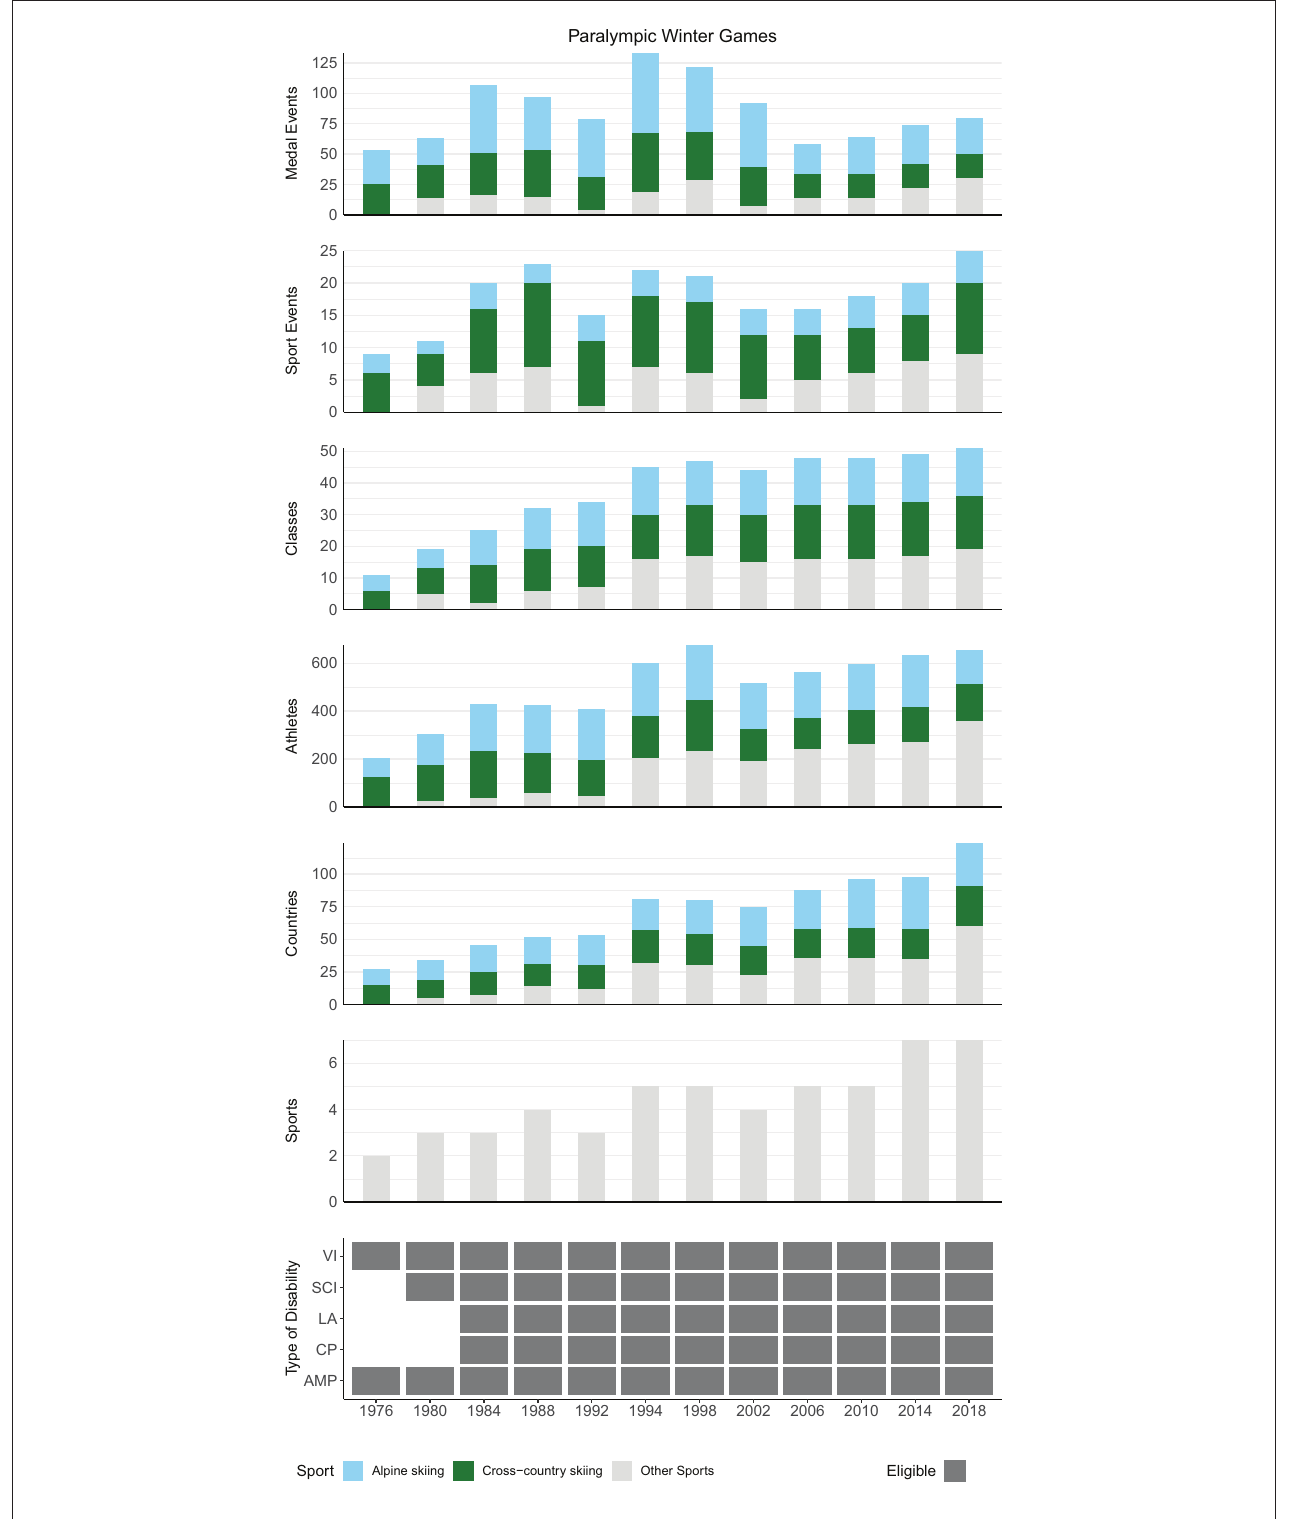
FIGURE 2 | Schematic overview showing the contribution of cross-country skiing and alpine skiing to the total number of medal events, sport events, and classes during each of the Paralympic Winter Games. Some sports have the same division of classes; in these cases, the number of classes was counted once per sport. In addition, some athletes and countries participated in more than one sport; in these cases, the number of athletes and countries were counted once per sport. VI, visual impairment; SCI, spinal cord injury; other impairments (LA, les autres); CP, cerebral palsy; AMP, amputation. For the number of unique countries, (see Table 3 ).